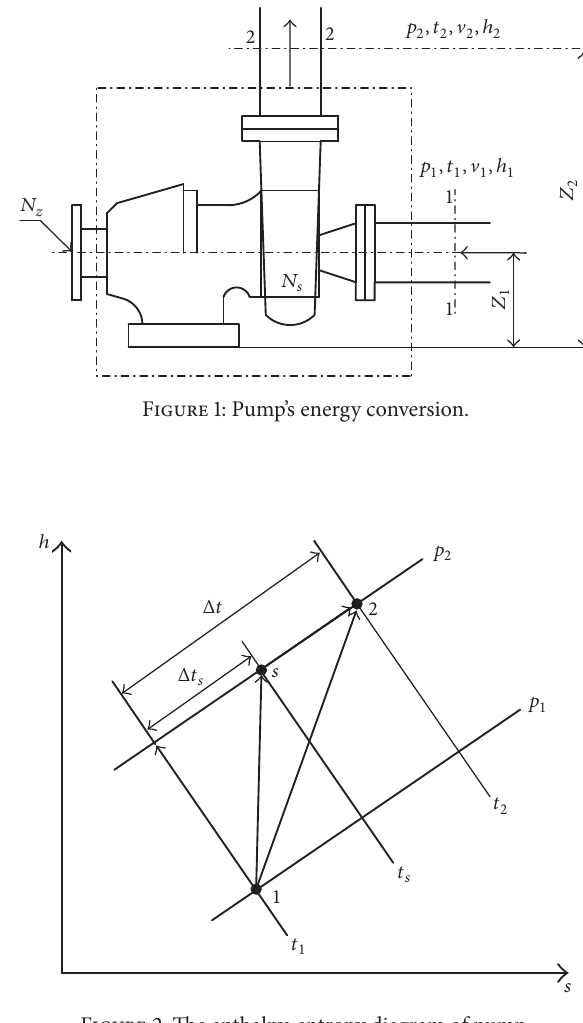
Figure 2: The enthalpy-entropy diagram of